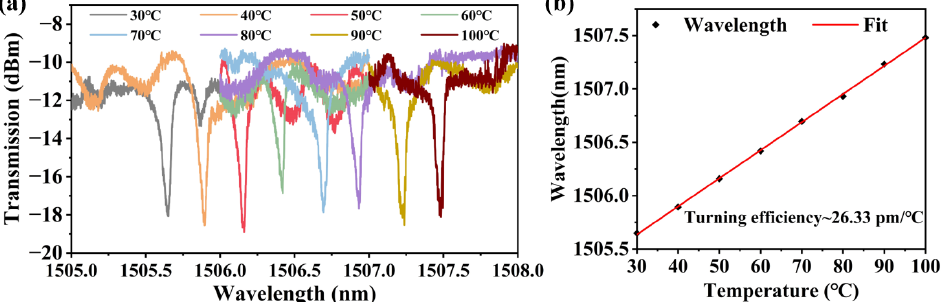
Figure 6. Temperature modulation of the microring resonator. ( a ) Experimental spectral measure- ments showing the shift of the resonant peak when the temperature is raised in 10 ◦ C increments. ( b ) Efficiency of temperature modulation fitting